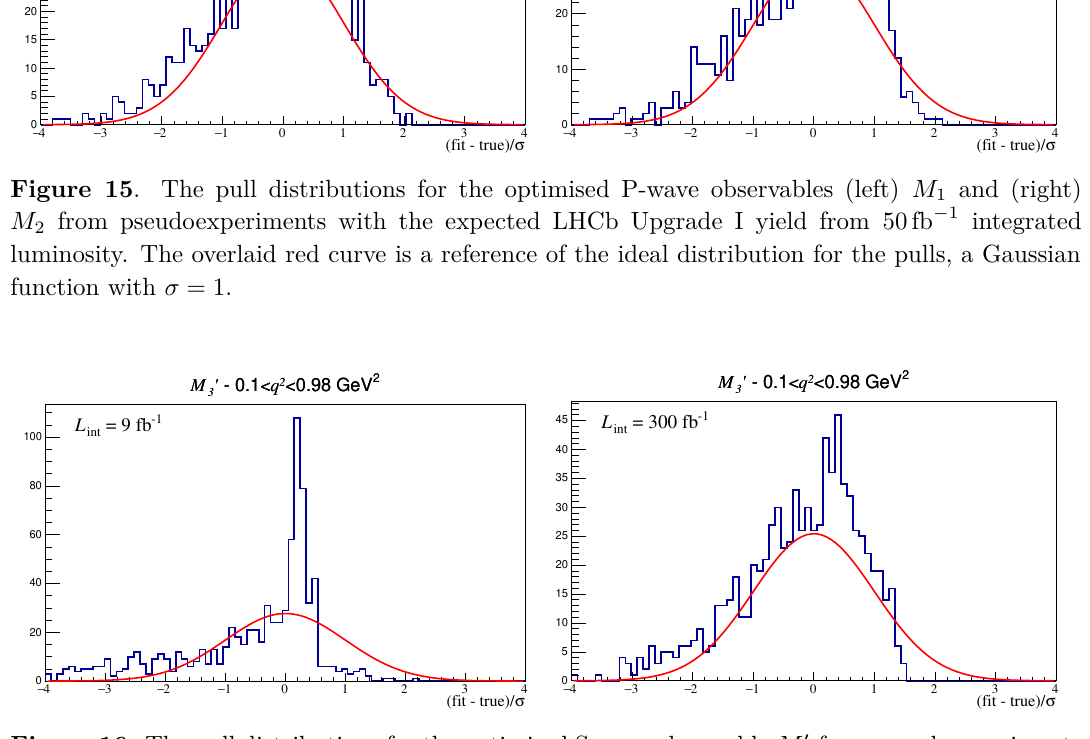
from pseudoexperiments 3